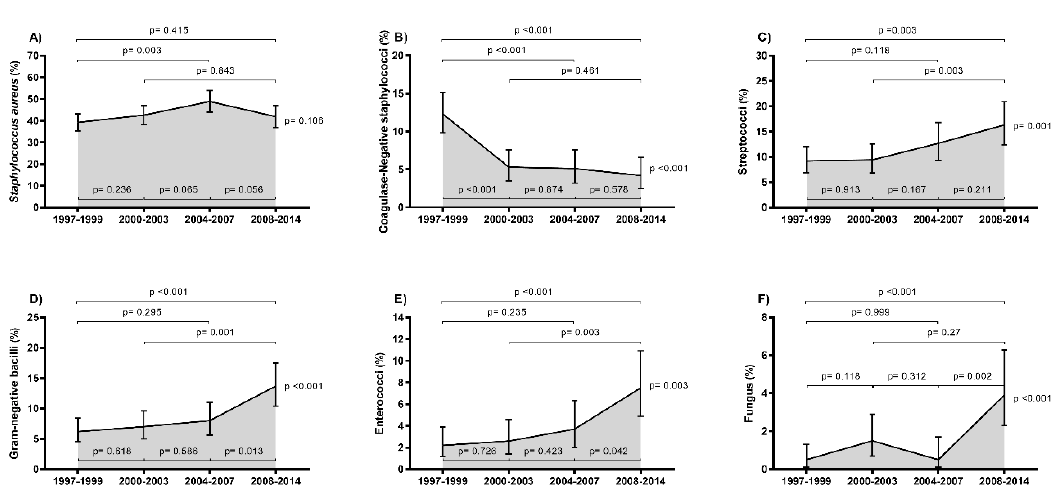
Figure 2. Epidemiological trends of infective endocarditis in HIV-infected patients in Spain (1997 to 2014). ( A ) Hospital admissions. ( B ) Incidence; ( C ) Mortality; ( D ) Case fatality rate. Statistical: